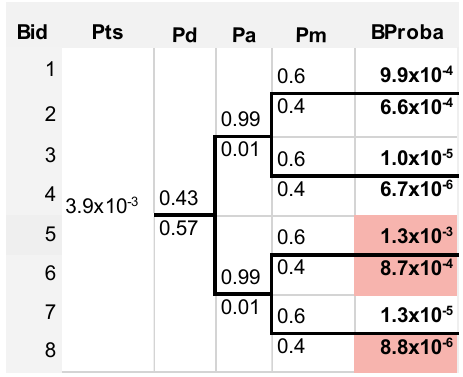
Figure 12. Event tree for the intrusion of an unauthorized drone in LIMC 35 departure path (>1 km from runway) when take-off is occurring.